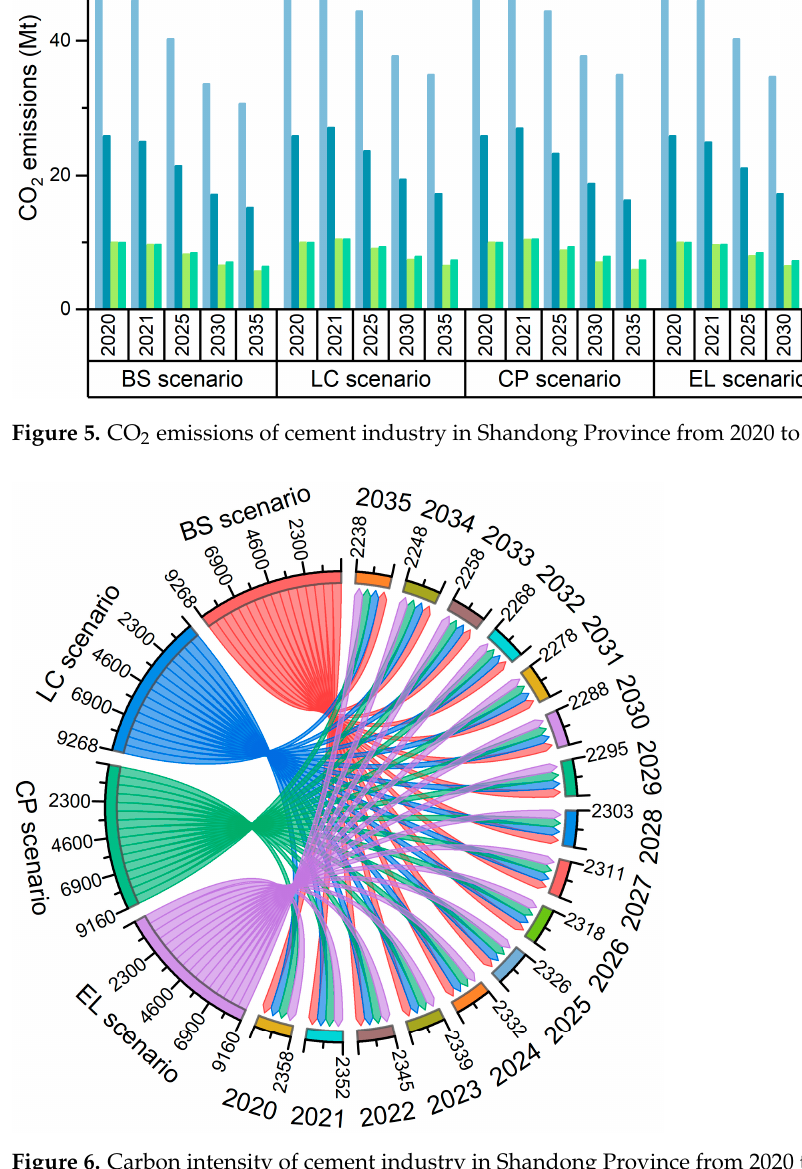
Figure 6. Carbon intensity of cement industry in Shandong Province from 2020 to 2035.